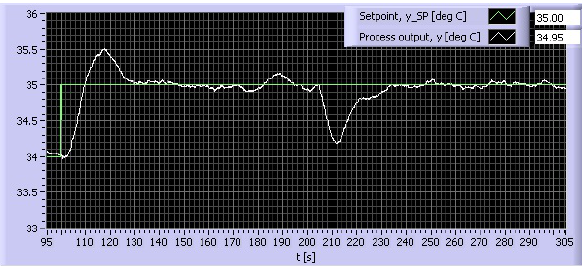
Figure 12: Ziegler-Nichols’ Ultimate Gain method: Re- sponses in the control